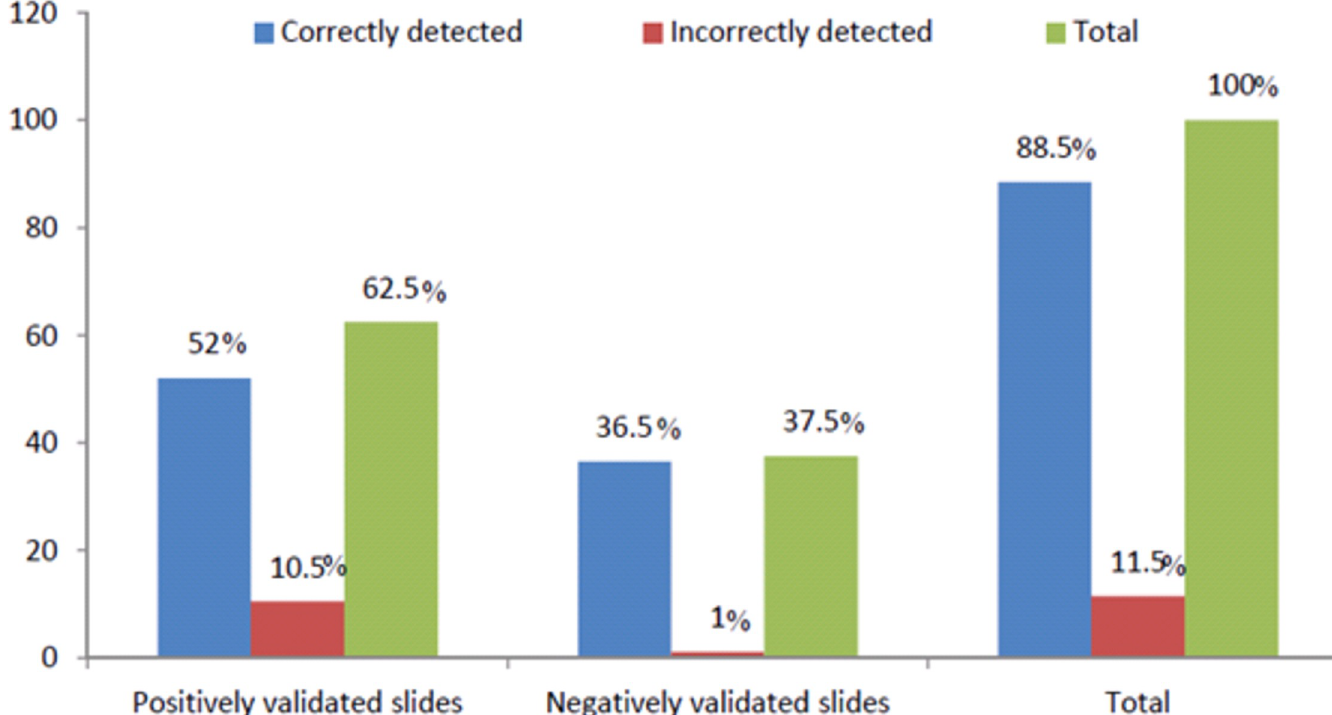
Fig 1. Performance of laboratory professionals participated on detection for Plasmodium parasites at health institutions in Bahir Dar city administration from January to March, 2017.